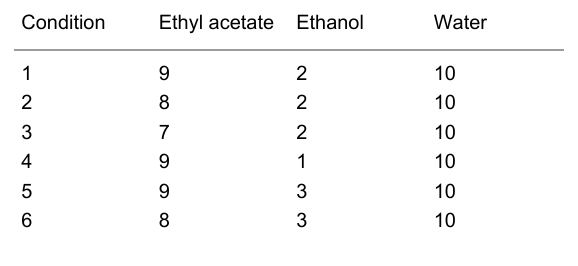
Table 1: Experimental conditions evaluated by using the shake-flask method.